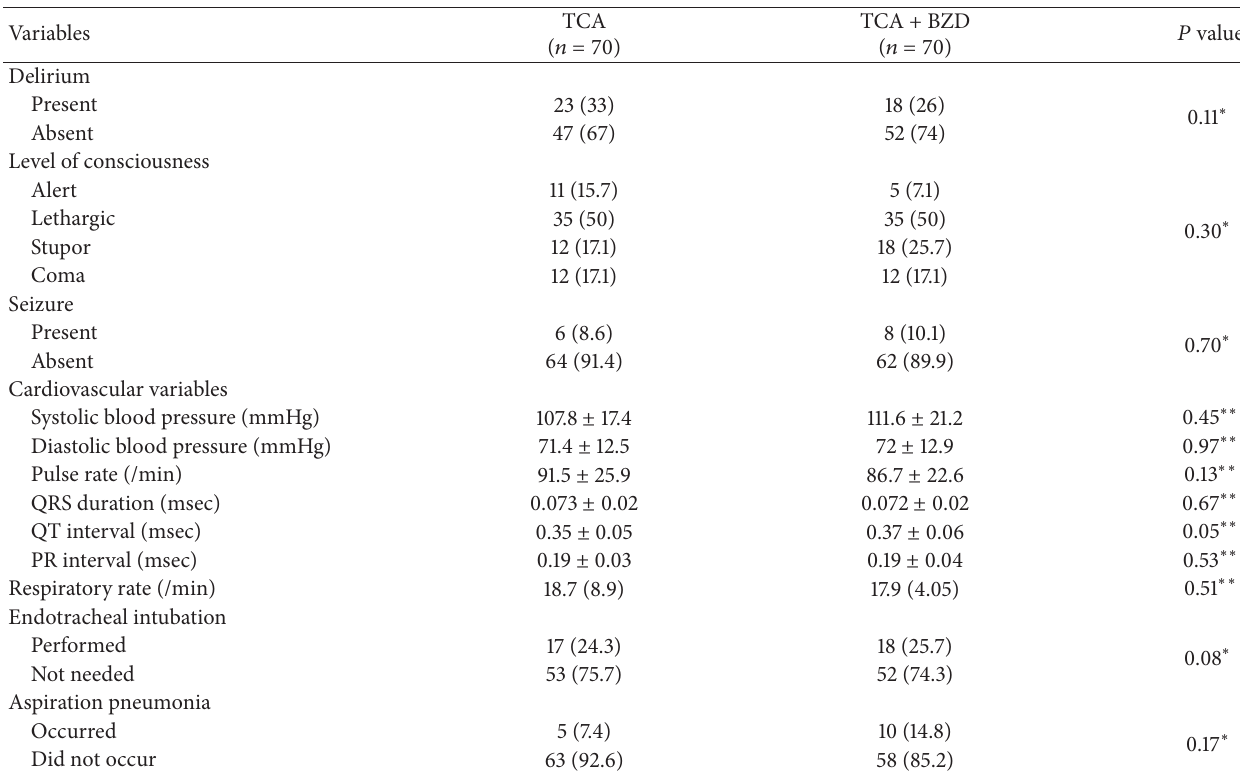
Table 2: Neurological, cardiovascular, and pulmonary characteristics of the studied patients at the time of admission and during